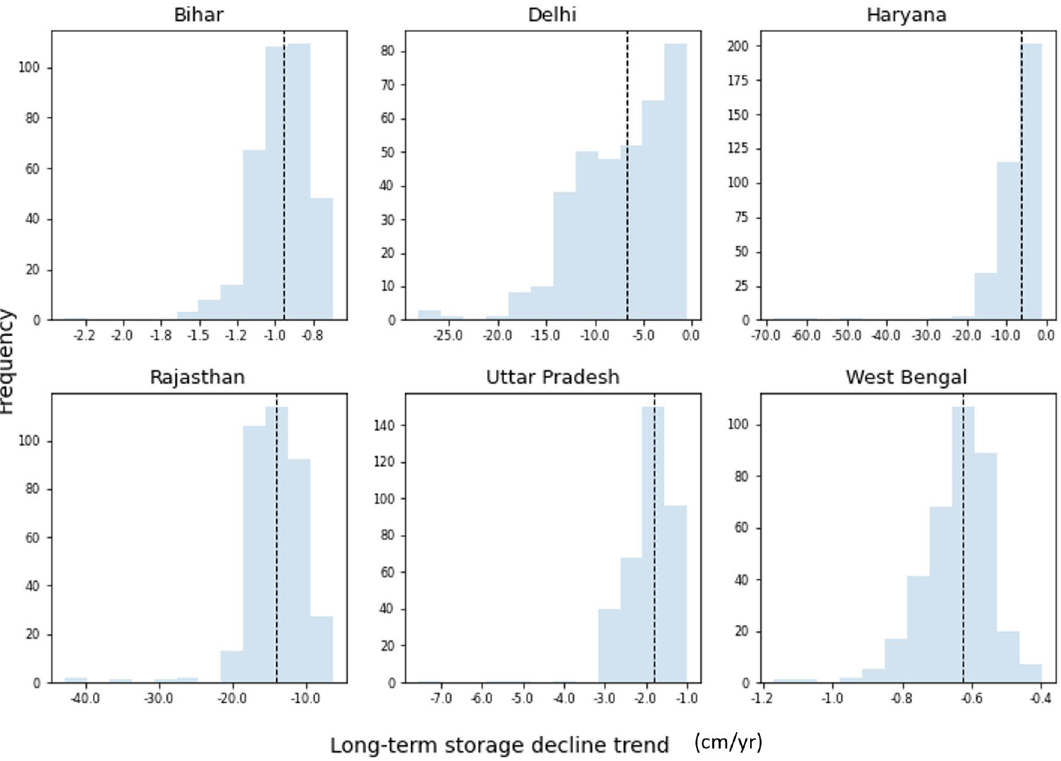
Figure 8. Distribution of simulated groundwater storage decline rate for 6 states located within the